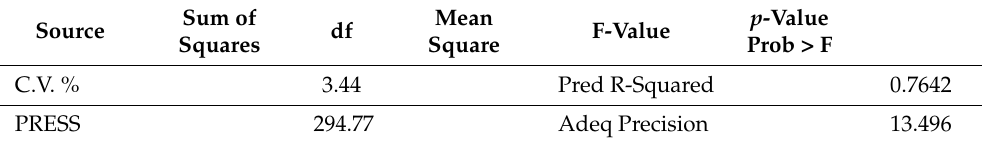
Table 3. Cont . Mean Sum of F-Value df Source Square Squares PRESS 294.77 Adeq Precision 13.496